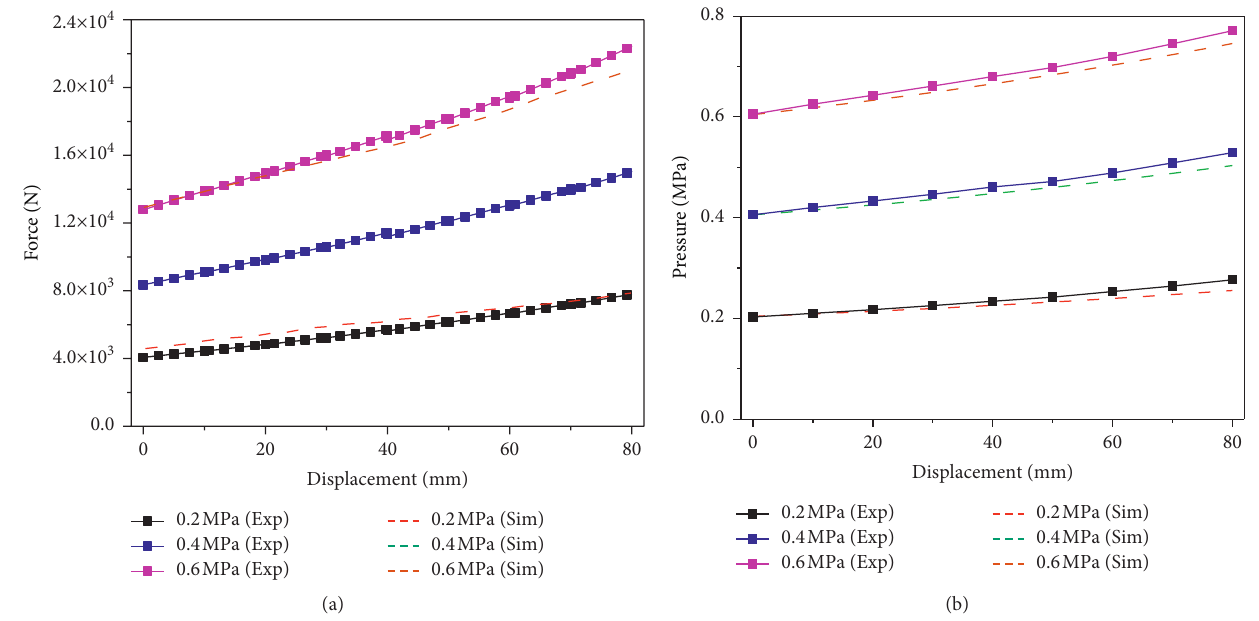
Figure 9: Experimental simulation results: (a) for force and (b) for